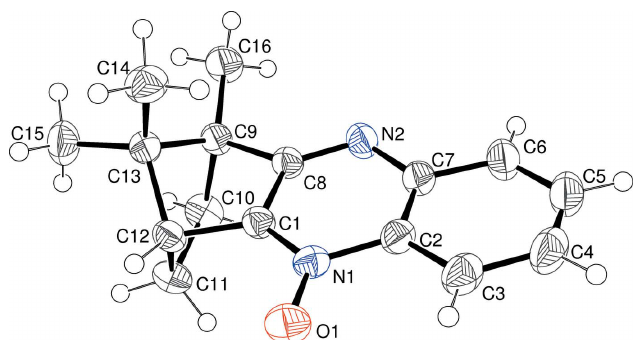
Figure 1 A view of the title compound. Displacement ellipsoids are drawn at the 50% probability